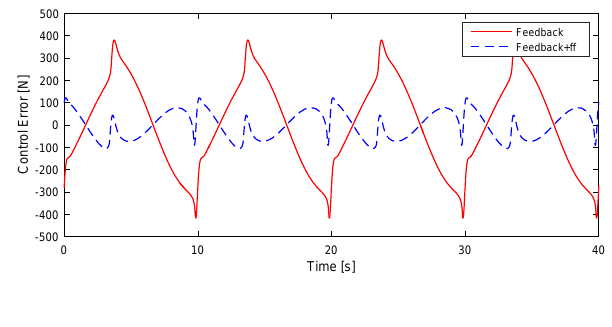
Figure 6: Force set point of 10 kN.